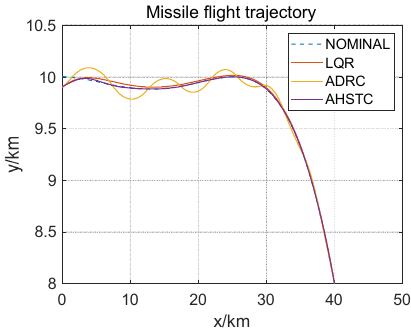
Figure 10. Trajectory tracking curve.